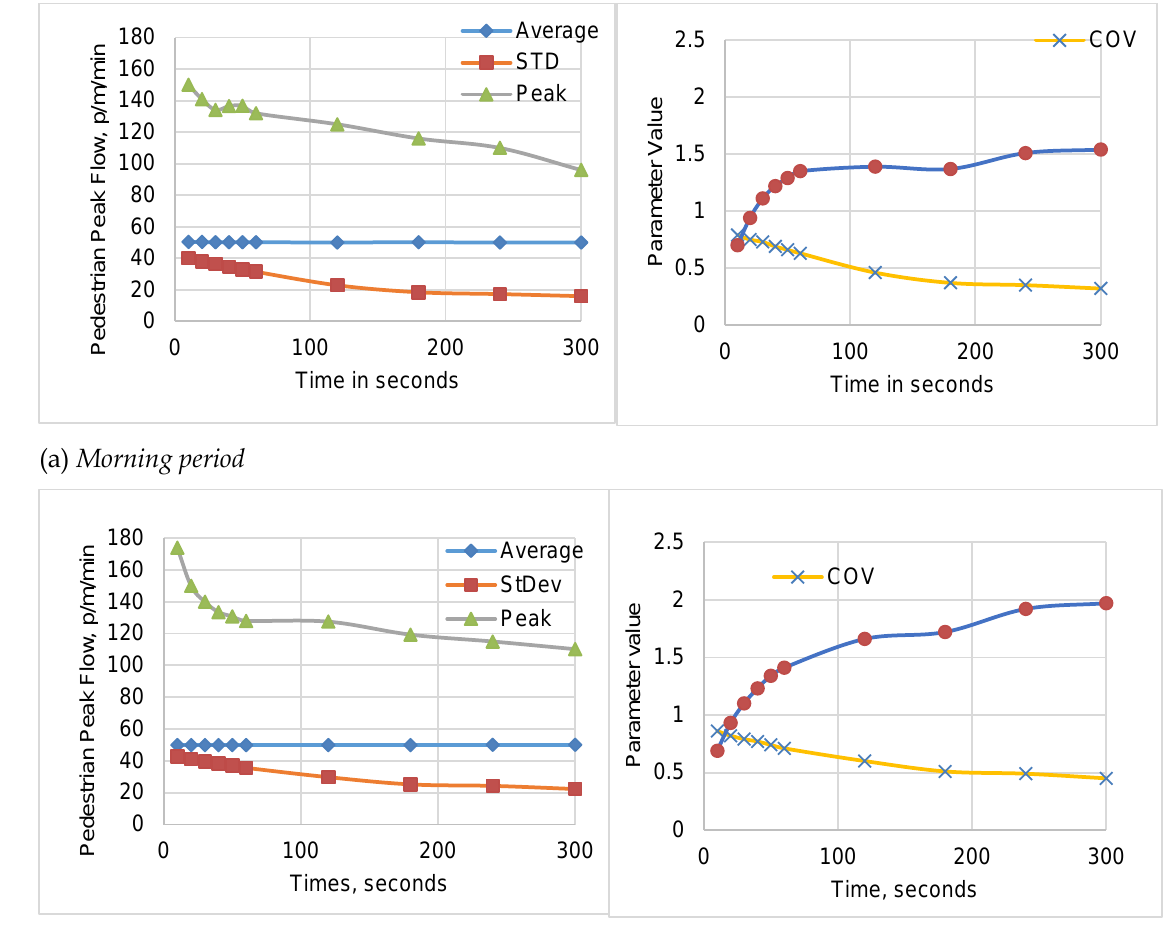
Figure 3. Variation in Statistical Flow Attributes and Parameters up to 300s Cumulative distribution for both morning and evening peak flows are shown in Figure 4. 98 th percentile peak flow was observed as 138 ped/m/min for morning and 147 ped/m/min for evening. The relationship between peak flow and count interval used for data extraction were examined using different distributions and based on their goodness-of-fit, exponential curve for morning and power curve for evening data was found to be the best (Refer Table 5 and Figure 5). Data extraction count interval corresponding to the 98 th percentile peak flows for morning and evening period was noted from the plots as 40s and 20s, respectively. This indicated that the analysis of pedestrian flows on escalators can be done using 20s peak flow (highest value) or 40s peak flow (lower value). This became the second limiting condition regarding the most optimal data extraction count